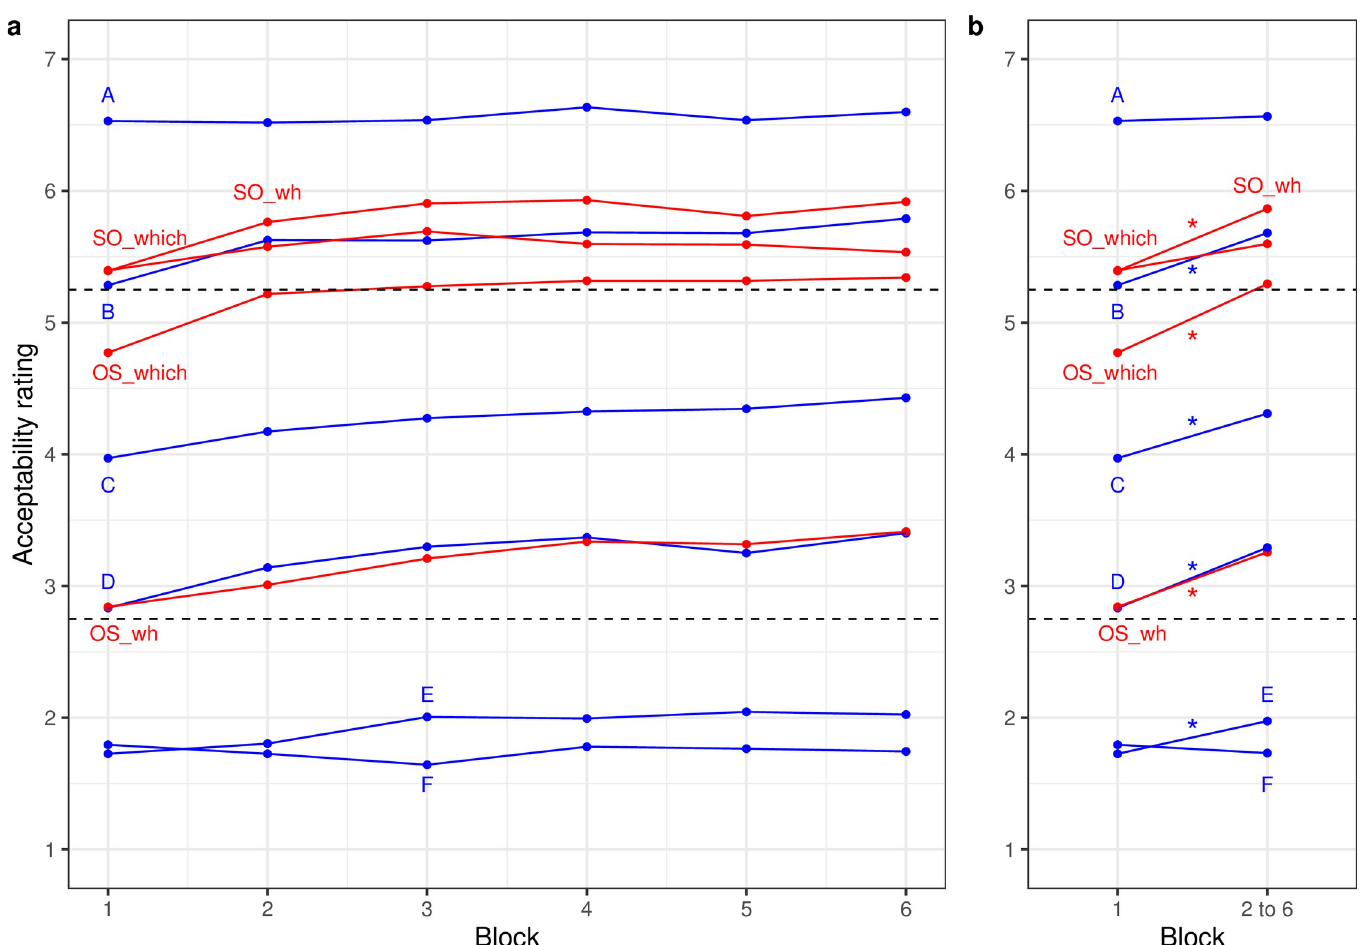
Fig 3. Well-formedness ratings (a) by block and (b) for first block and mean of later blocks for English targets and fillers (lab experiment). Dashed lines indicate the upper and lower bounds of the satiation zone based on the 25% criterion. Asterisks indicate significant changes (p < 0.05).